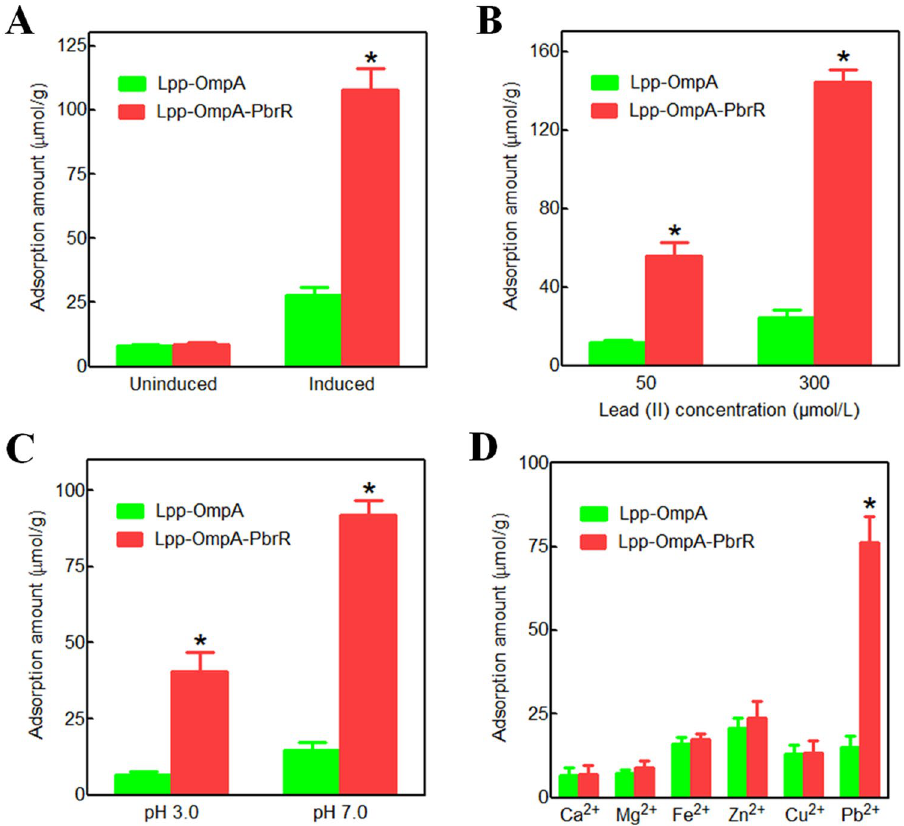
Figure 3. Contribution of surface displayed PbrR to enhanced adsorption of lead(II) in vitro . ( A ) Accumulation of lead(II) by cells surface-displayed Lpp-OmpA-PbrR. The adsorption assay was performed in 25 mmol/L HEPES pH 7.0 containing 150 μ mol/L lead acetate at 25 °C for 12 h. ( B ) Lead(II) adsorption capacity of cells surface-displayed Lpp-OmpA-PbrR in different concentrations of lead solution. The assay was performed in 25 mmol/L HEPES pH 7.0 containing 50 or 300 μ mol/L lead acetate at 25 °C for just 1 h. ( C ) Effect of pH value on lead ion adsorption by cells surface-displayed Lpp-OmpA-PbrR. The assay was performed in 25 mmol/L acetate pH 3.0 or 25 mmol/L HEPES pH 7.0 containing 150 μ mol/L lead acetate at 25 °C for 1 h. ( D )